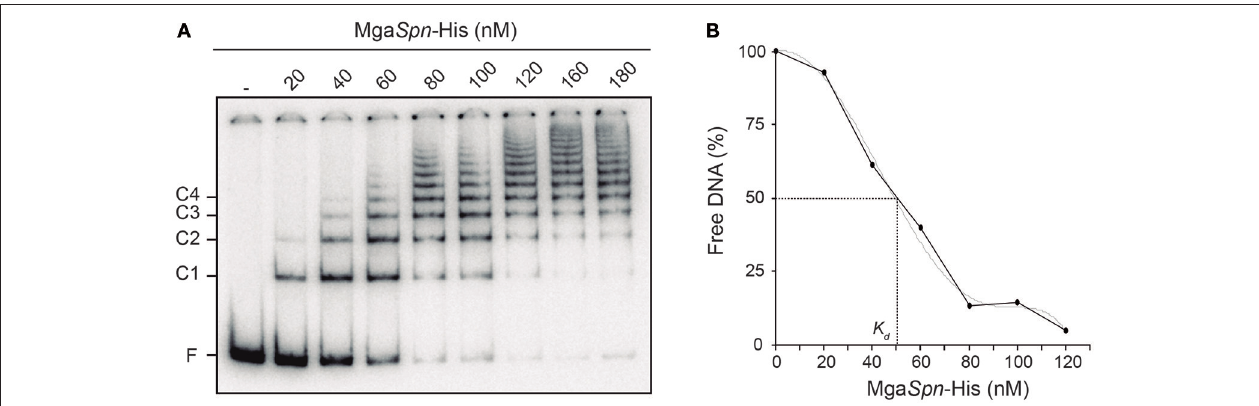
FIGURE 2 | Binding of Mga Spn -His to the 288-bp hlyR DNA fragment. (A) EMSA. The 32 P-labeled hlyR DNA fragment (2 nM) was incubated with increasing concentrations of Mga Spn -His (20 to 180 nM). Free and bound DNAs were separated by native gel electrophoresis (5% polyacrylamide). Bands corresponding to free DNA (F) and to several protein-DNA complexes (C1, C2, C3, and C4) are indicated. (B) Affinity of Mga Spn -His for the 288-bp hlyR DNA fragment. The autoradiograph shown in A was scanned, and the percentage of free DNA was plotted against Mga Spn -His concentration.